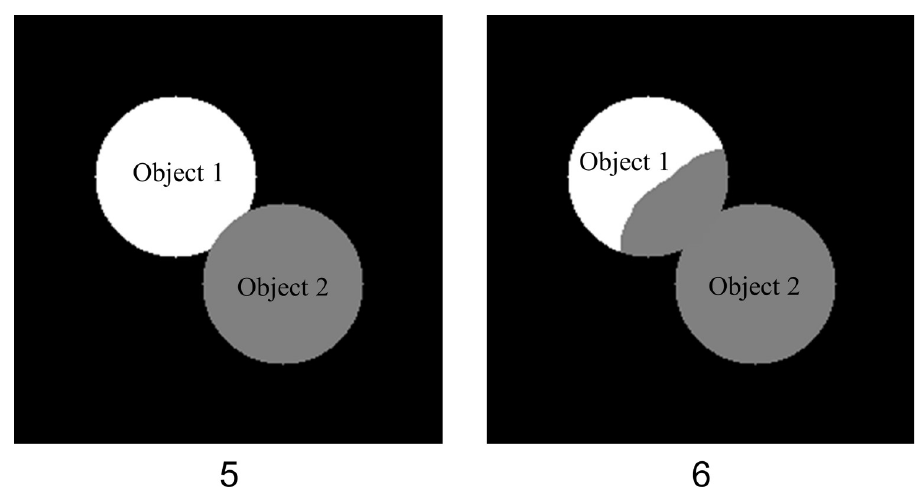
Fig 3. Simulated grayscale images of adjacent objects created to compare the evaluation performance of POSEA and traditional pixel-level analysis for images with pixels misassigned to an adjacent object.